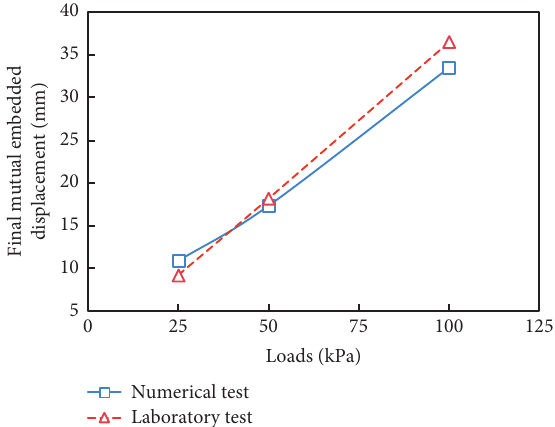
Figure 11: Comparison between numerical and laboratory test.